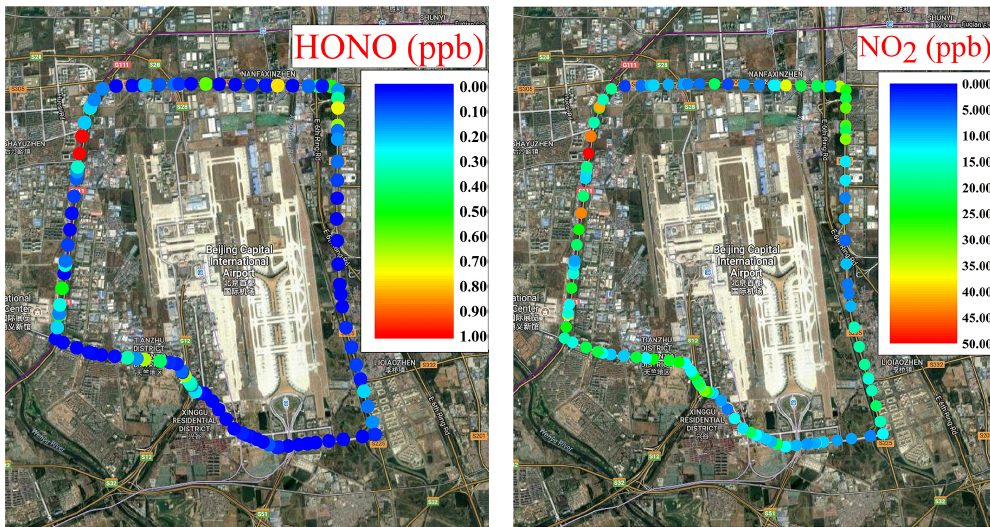
Figure 11. Results of the HONO and NO 2 around Beijing International Airport. Table 1. Characteristics of typical IBBCEAS instruments for HONO measurements. Time Detection limit